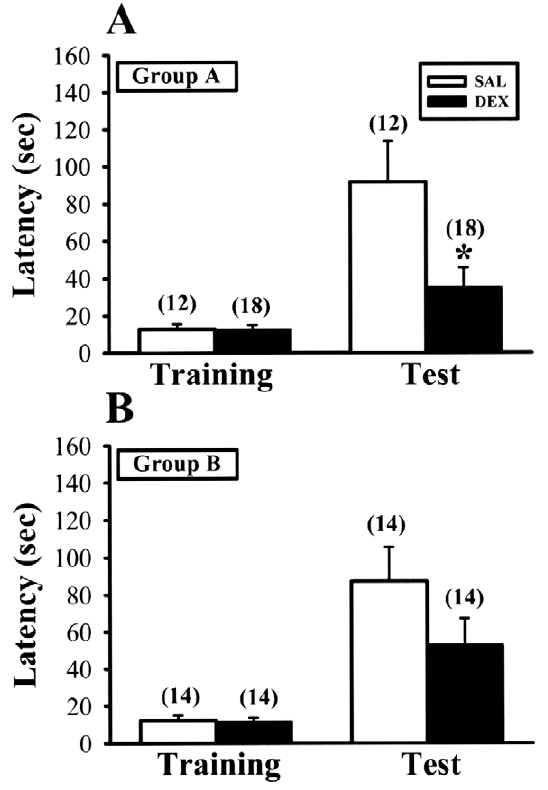
Figure 8. Culling rescues neonatal DEX treatment-induced impairment of memory retention for one-trial passive avoid- ance task at 5 weeks old. (A) Retention performance in one-trial passive avoidance task is expressed the latency time required for the animal to enter the dark compartment. Summary bar graphs depicting the latencies to enter the dark compartment on retention testing session in 5-week-old rats neonatally treated with SAL or DEX for Group A. (B) Summary bar graphs depicting the latencies to enter the dark compartment on retention testing session in 5-week-old rats neonatally treated with SAL or DEX for Group B. The total number of animals examined is indicated by n in parenthesis. Data represent the mean 6 SEM. *p , 0.05 compared with SAL-treated